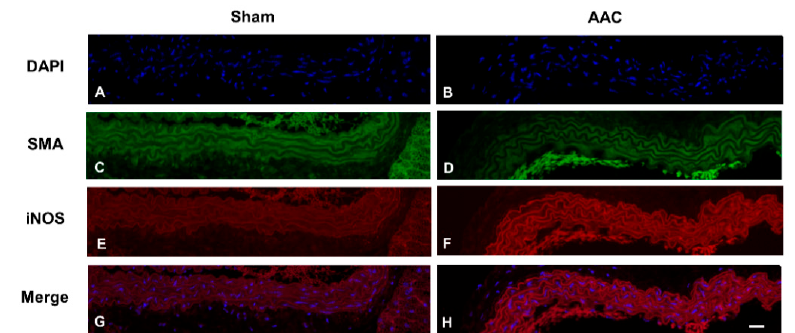
Figure 5. Abdominal aortic constriction (AAC)-induced iNOS expression in the aorta of mice. Immunofluorescence images of iNOS (red) and smooth muscle actin (SMA, green) in the aortas of sham and AAC mice 6 h post-operation. Tissue sections were co-stained with DAPI ( A , B , blue), anti-SMA ( C , D ) and anti-iNOS ( E , F ) antibodies. The Merge is the overlapping of iNOS and DAPI ( G , H ). The uncropped pictures of immunohistochemical analysis are shown in Figure S1. Representative images from four individual animals in each group are shown. Original magnification, 400× (scale: 20 µ m).